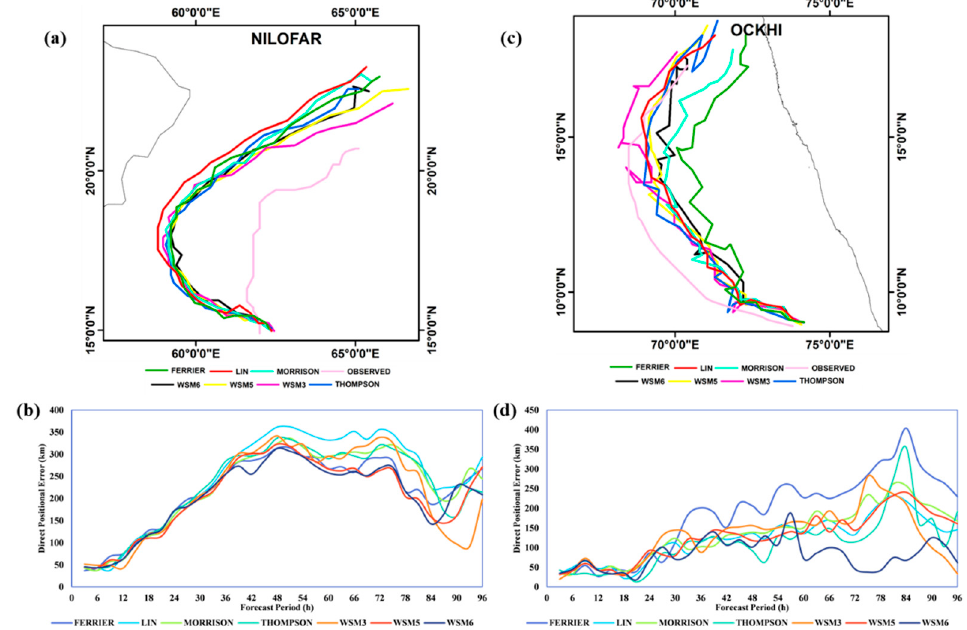
Figure 5. Observed and predicted tracks of tropical cyclones initiated at severe cyclonic stage along with DPE ( a ) track of Nilofar Cyclone, ( b ) DPE of Nilofar Cyclone, ( c ) track of Ockhi Cyclone, ( d ) DPE of Ockhi Cyclone.